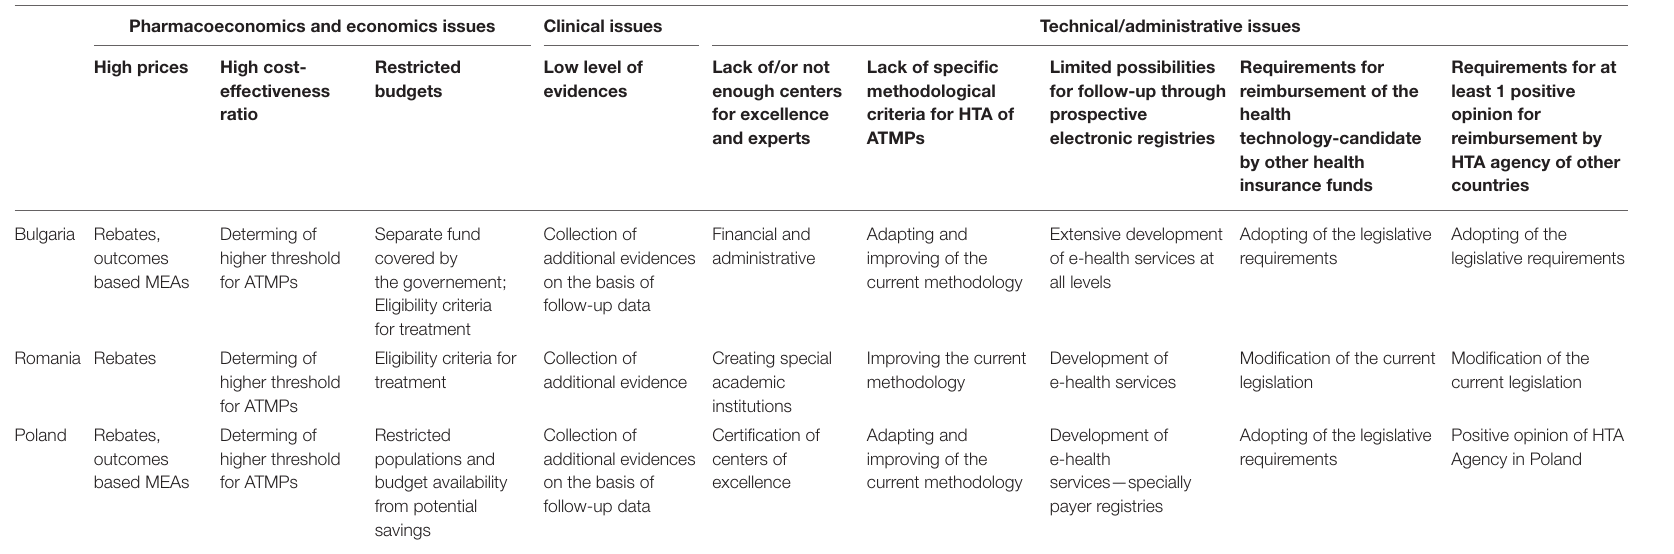
TABLE 4 | Recommendations for overcoming the